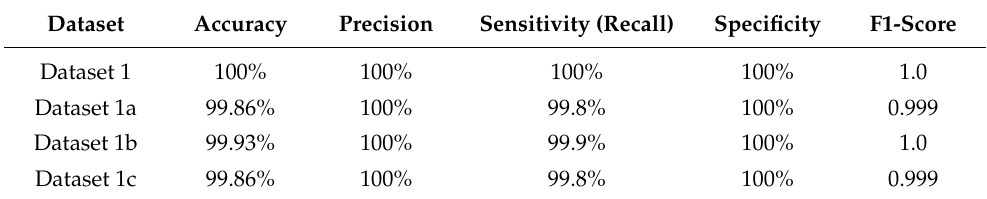
Table 7. The evaluation indicators tested on different